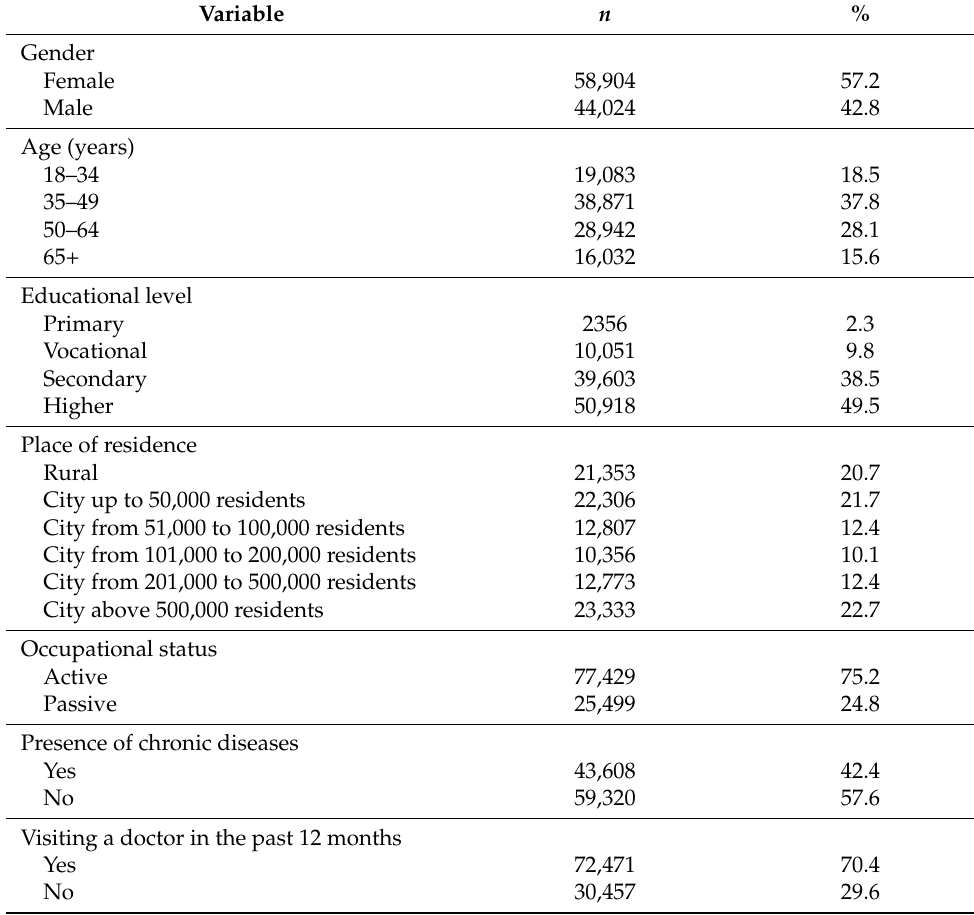
Table 1. Characteristics of the study population ( n = 102,928).